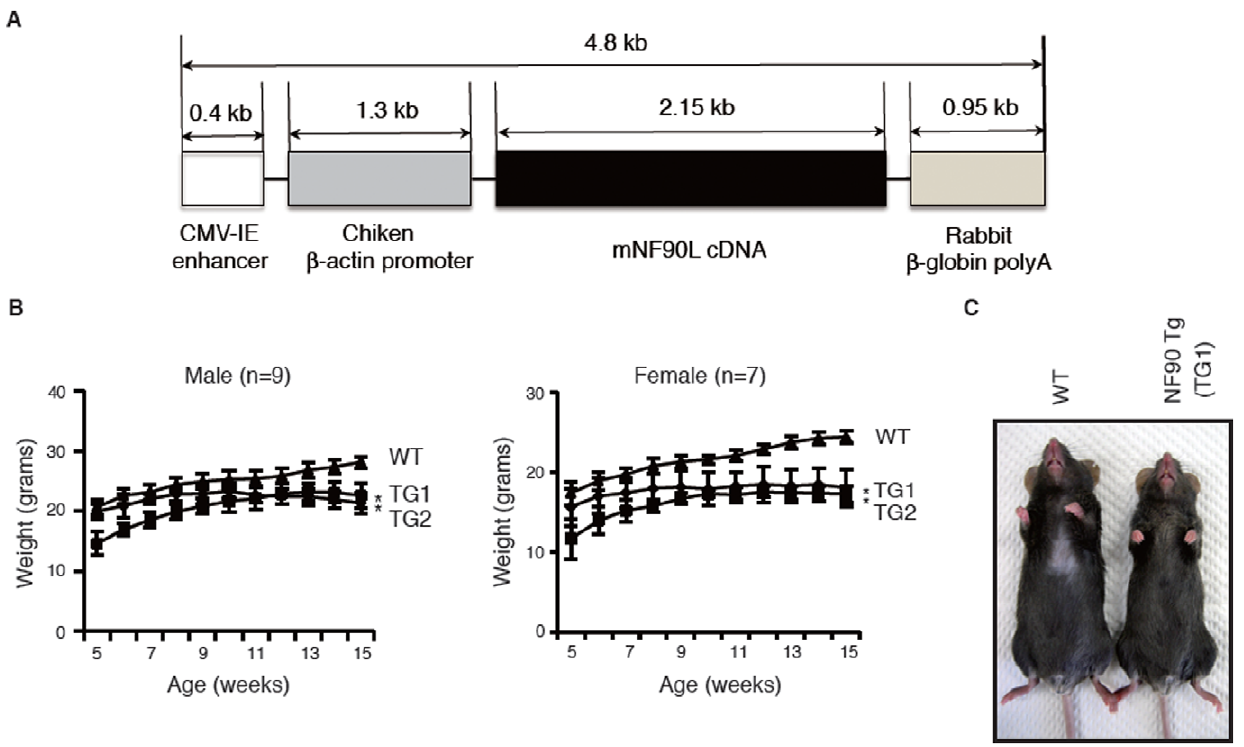
Figure 1. Structure of the NF90 transgene and body growth rates of wild-type (WT) and NF90 transgenic (Tg) mice. (A) NF90 transgene construct used to generate transgenic mice. (B) Growth curves of WT and two lines NF90 Tg male (n=9) and female (n=7) mice (lines TG1 and TG2) from the age of 5 weeks through 15 weeks. Data are expressed as means 6 SD. *, p , 0.0001 relative to WT by a two-tailed Student’s t test. (C) Photograph of whole body from WT and NF90 Tg male mice (line TG1) at 12 weeks of age. (Figure 5). On the other hands, we also tested whether apoptosis is induced in the skeletal muscles of the NF90 Tg mice. As shown in Figure S6, cleaved caspase-3 and -6, which are key modulators of the apoptotic pathway, were not found in the NF90 Tg mice.